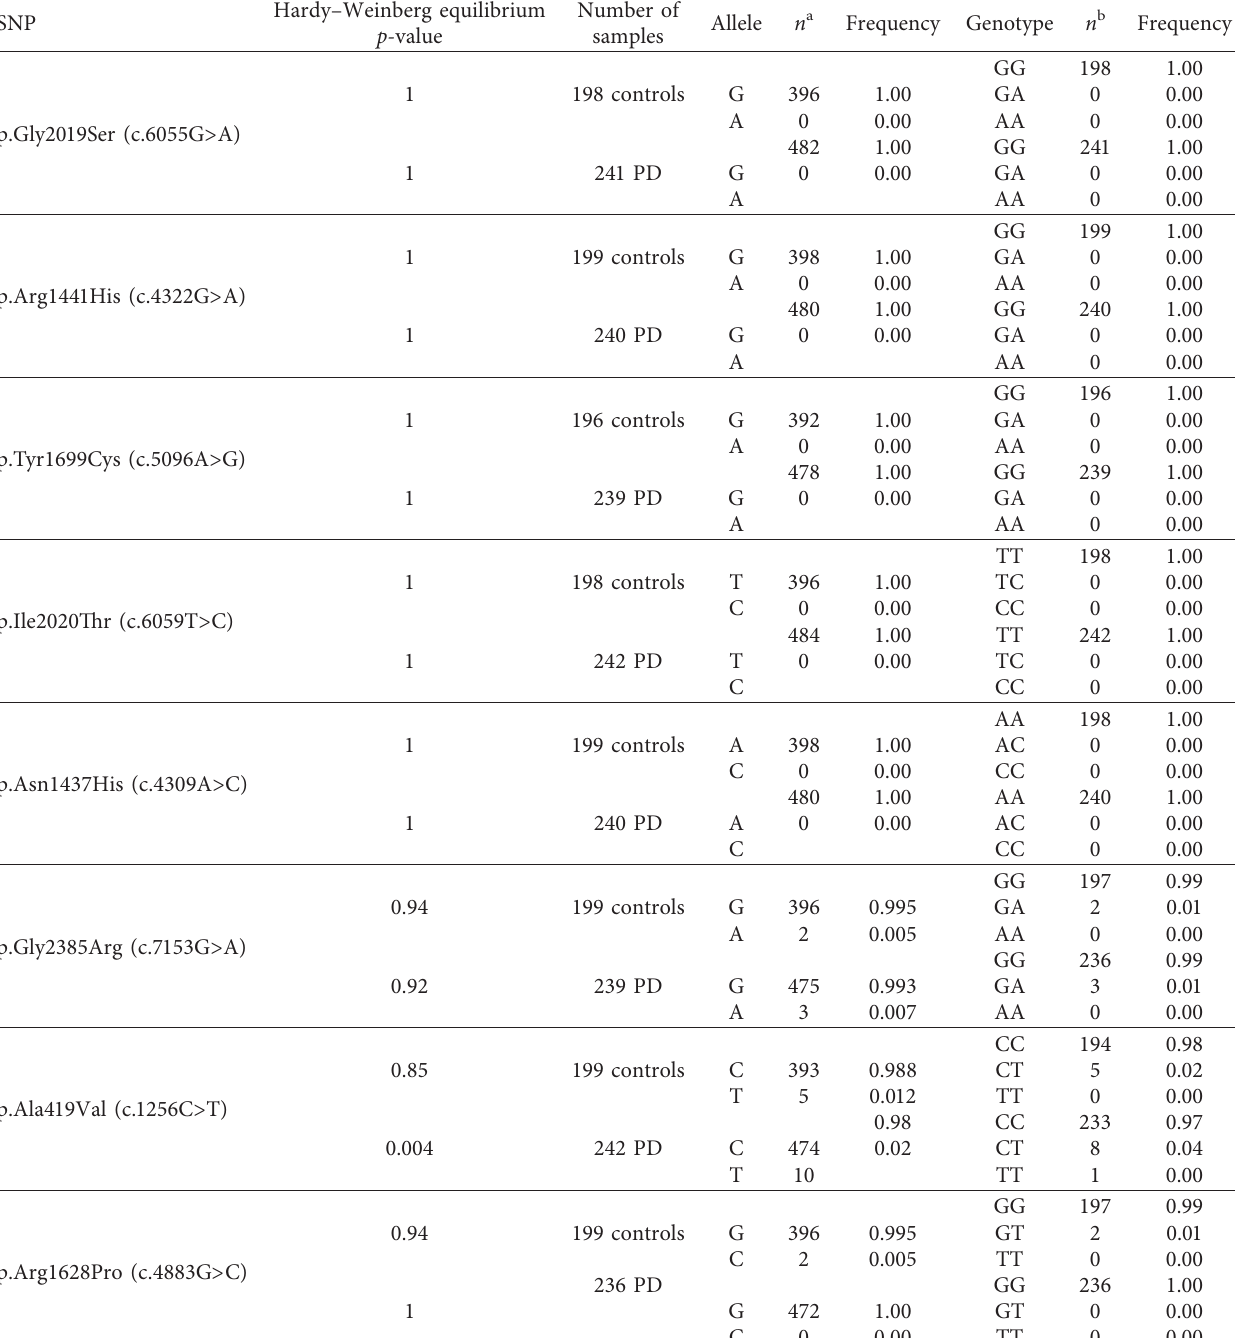
Table 2: Allele frequency and distribution of the 8 tested LRRK2 variants.